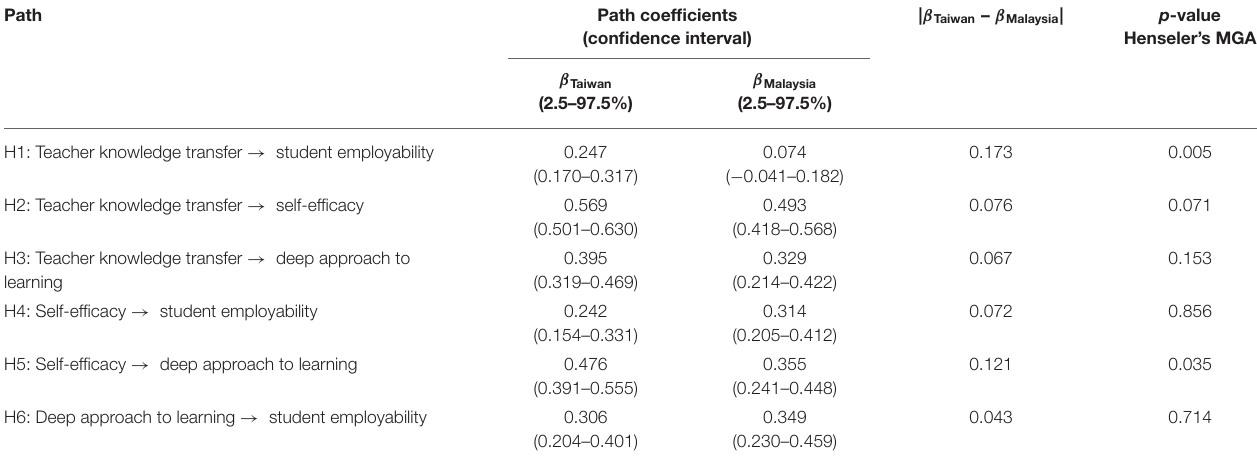
TABLE 4 | Multigroup analysis